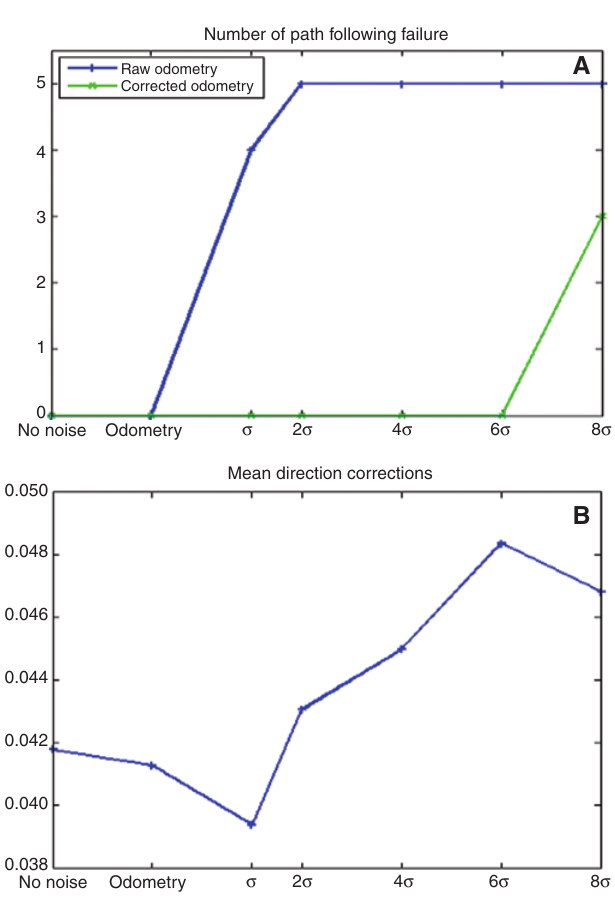
Figure 18. (A) Number of Failed Path Following over Five Trials Using Raw Odometry (Blue) and the Qualitative Position Esti- mated by Our Algorithm (Green) for Several Levels of Simulated Odometry Noise. (B) Mean Direction Correction Applied during Path Following, in